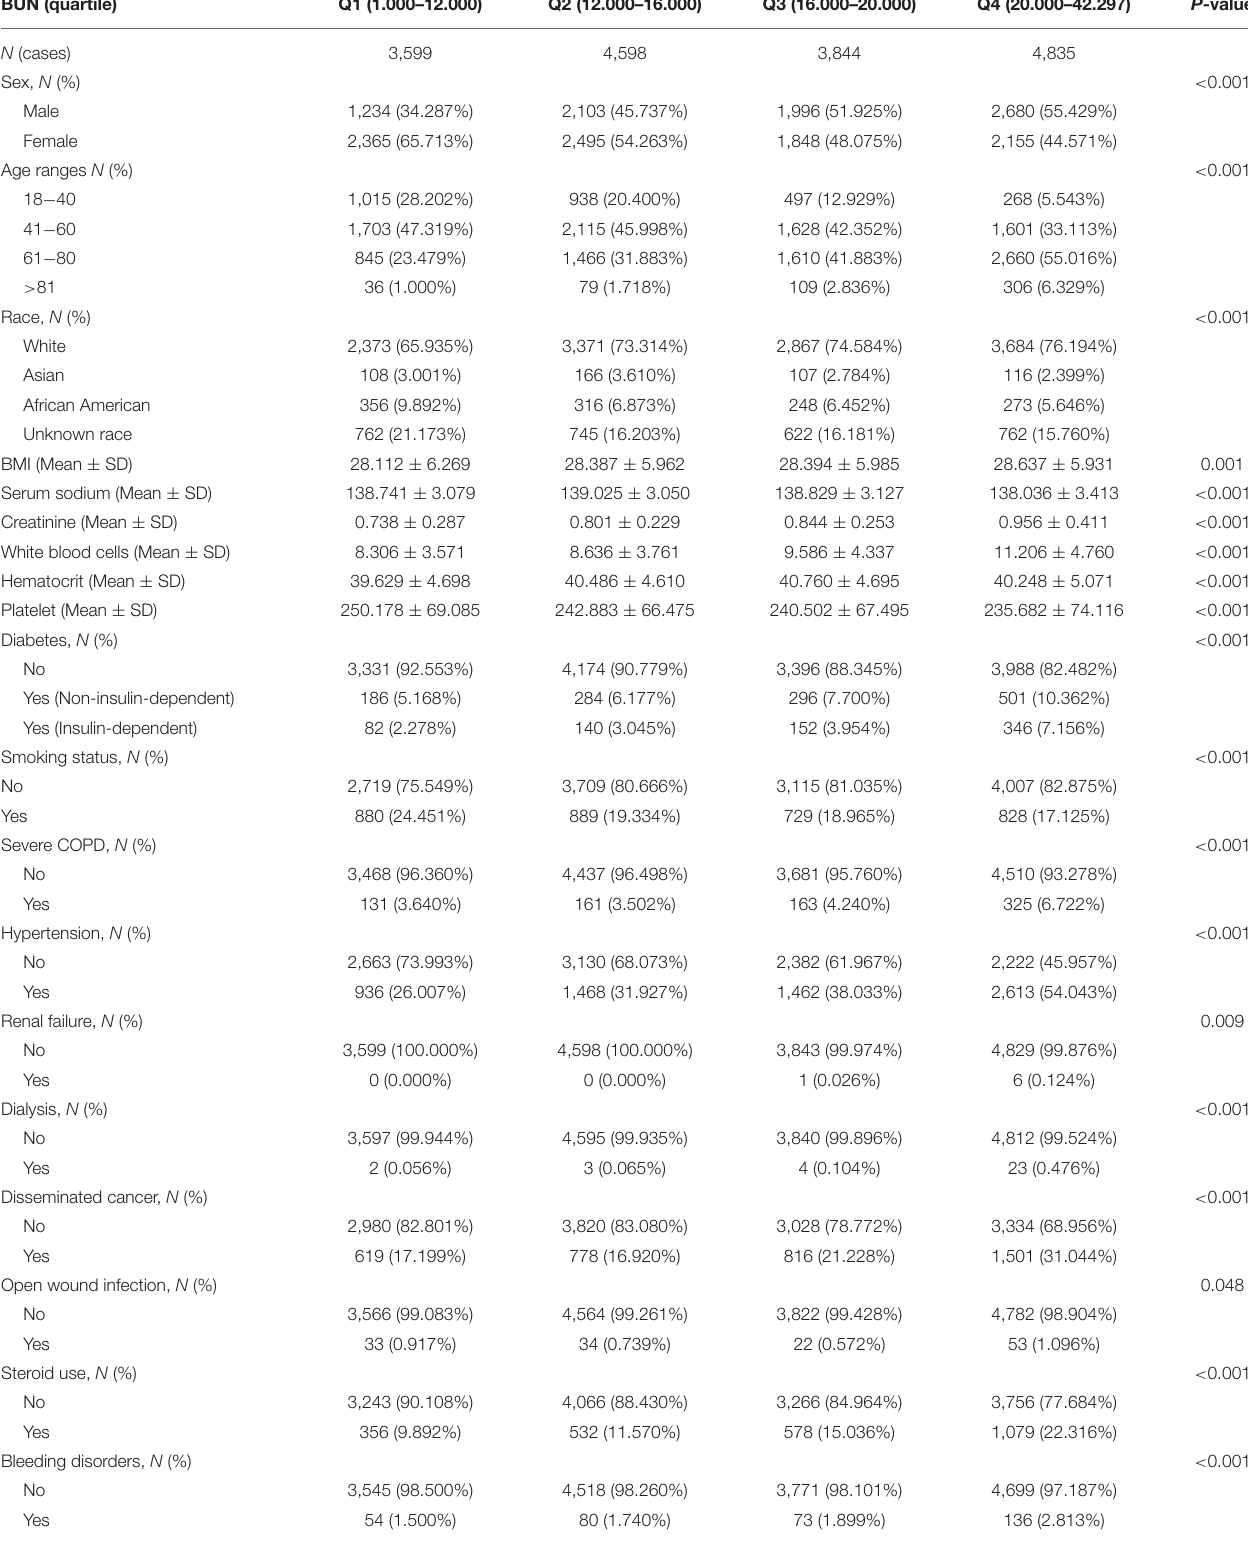
TABLE 1 | Baseline characteristics of